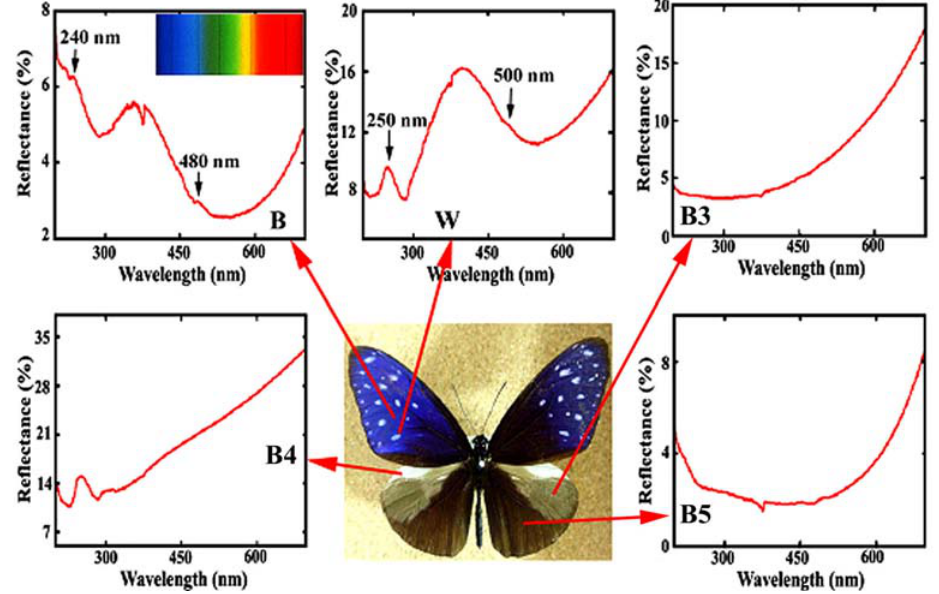
Figure 4. Reflectance spectrum (UV and visible region) from different areas in the dorsal wings of the male E. mulciber. Small caves at 375 nm were caused by a change of the incident light source so that they should be neglected. Inset is the spectrum of sunlight (adapted from